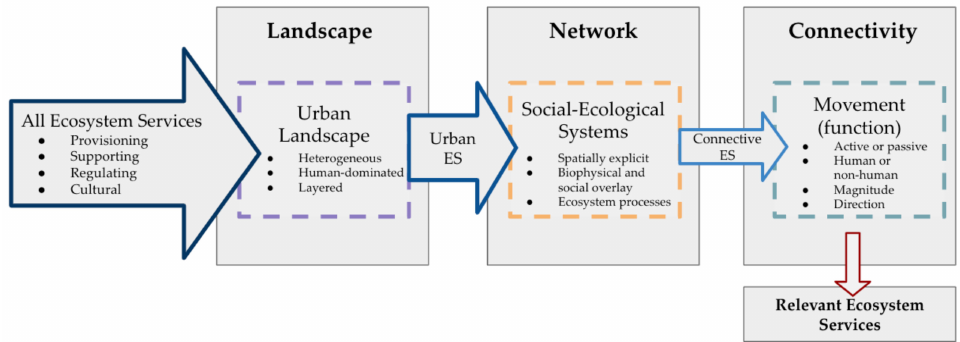
Figure 1. Conceptualization to identify ecosystem services that are well-suited to social-ecological connectivity analyses. Ecosystem services, outlined in the Millennium Ecosystem Assessment [35], consist broadly of the provisioning, supporting, regulating, and cultural benefits that nature and also green spaces in cities provide to support human well-being. Social-ecological connectivity can support the movement of ecologically-relevant actors across a network, thus supporting ecosystem services. When considering the function and utility of an ecosystem services framework to support an understanding of social-ecological connectivity in cities, we must hone our selection of relevant ecosystem services by considering the nuances of the urban landscape, the requisite movement implied by connectivity studies, and the overall application in a